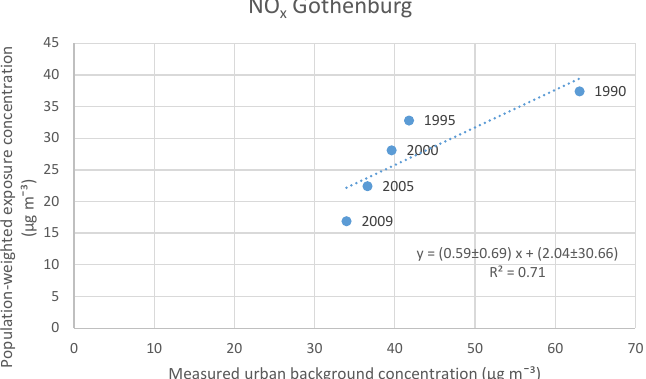
Figure A2. Relationship between measured urban background concentrations and population-weighted exposure concentrations of NO x in Gothenburg. Slope and intercept are specified with 95% confidence intervals.